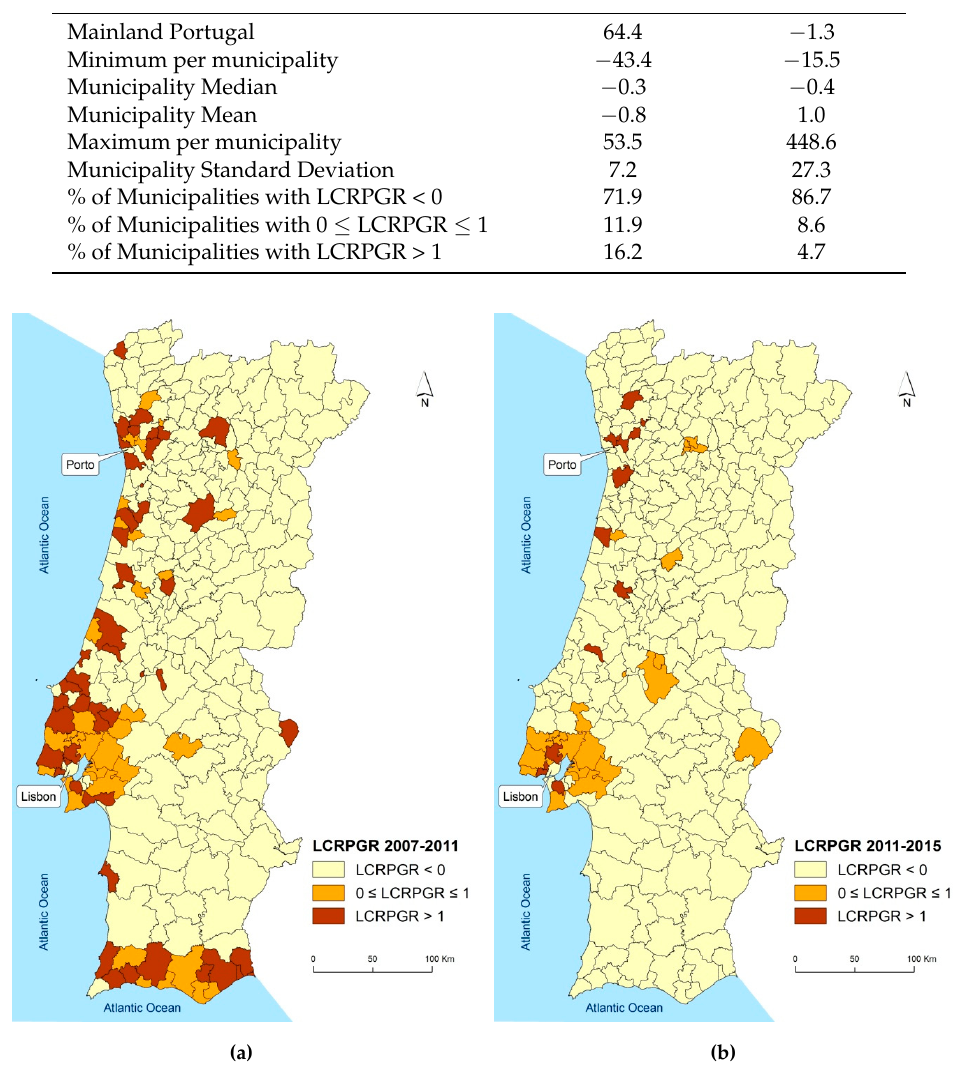
Figure 4. LCRPGR estimates per municipality for 2007–2011 (a) and 2011–2015 (b).